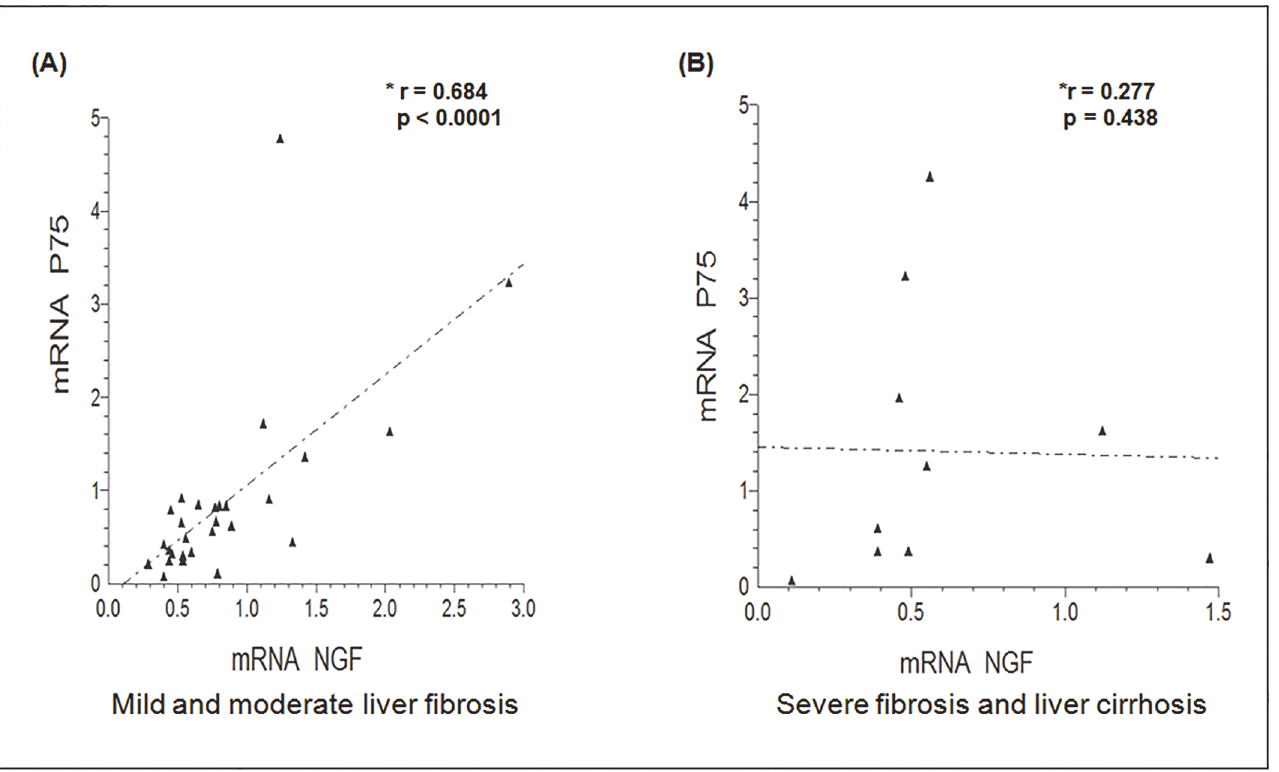
Fig 3. Correlation of p75 NTR and NGF mRNA levels with fibrosis and cirrhosis stages. A, B: Spearman correlation analysis with mild to moderate fibrosis stages and severe fibrosis and cirrhosis stages.